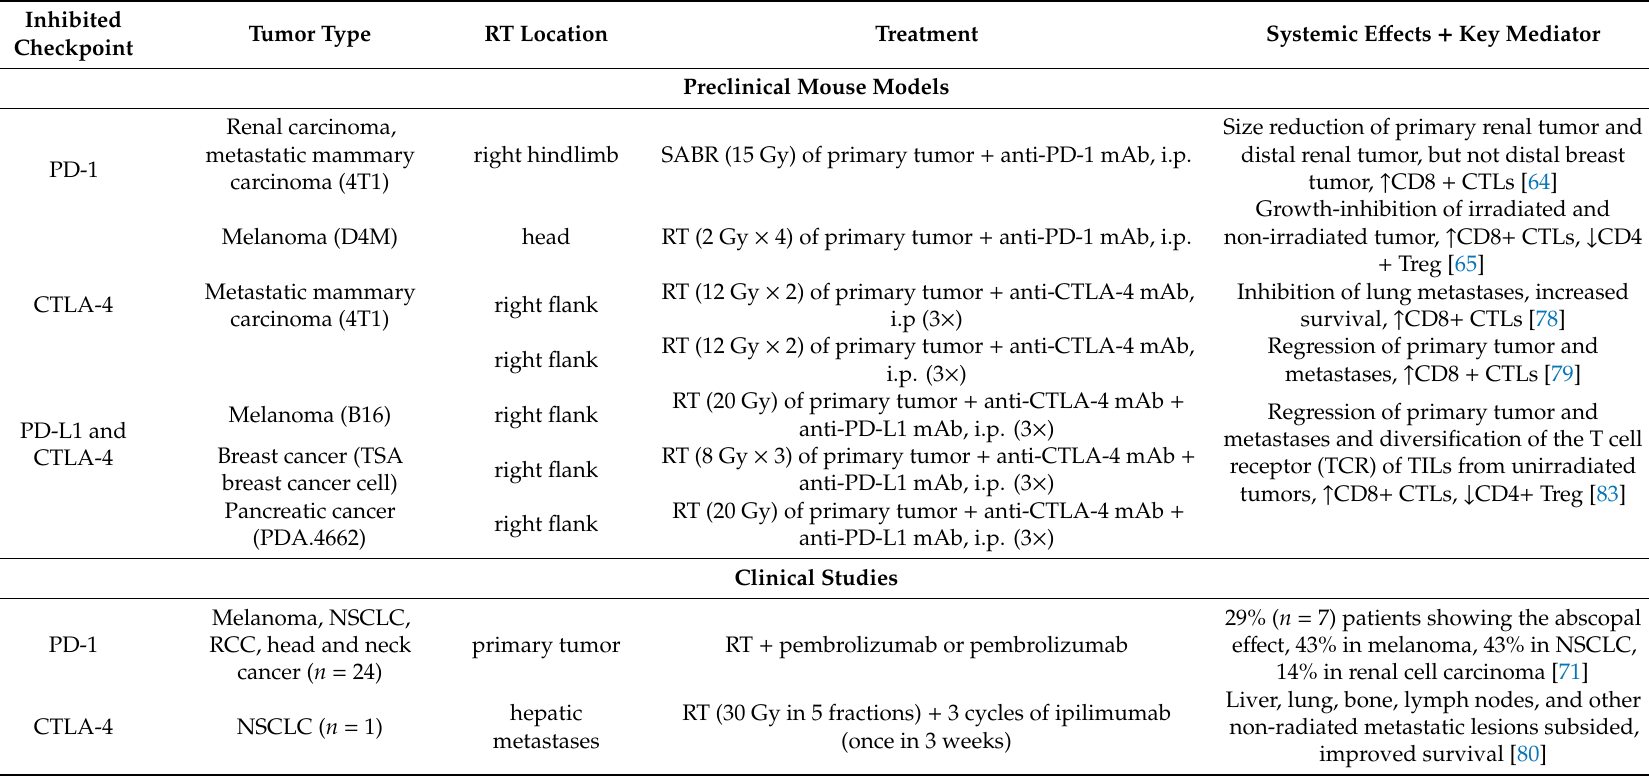
Table 1. Systemic e ff ects observed in preclinical and clinical studies after RT combined with immune checkpoint